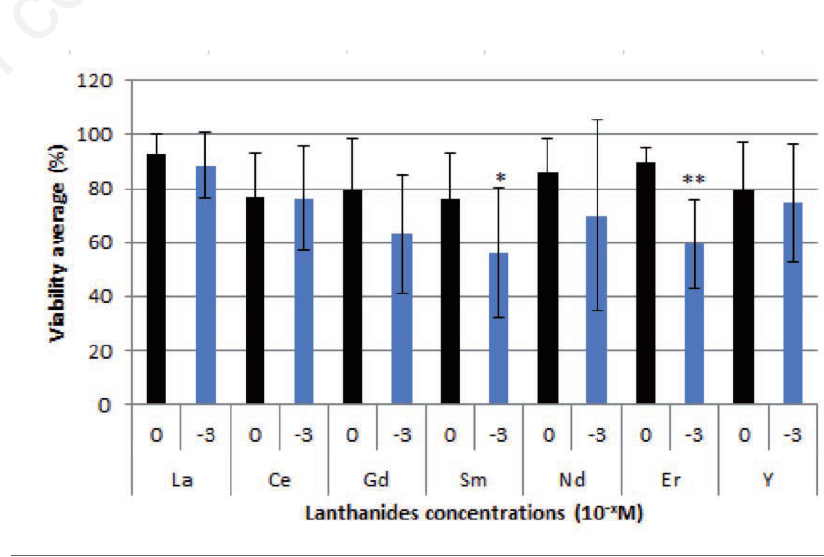
Figure 1. Average Mytilus edulis cell viability (%) after 21 h of exposure to lanthanides ranging from 0 to 10 −3 mol*L −1 (M), significant results are presented with an asterisk. Figure shows averages but some statistical tests were produced with median when the dis- tribution failed normality